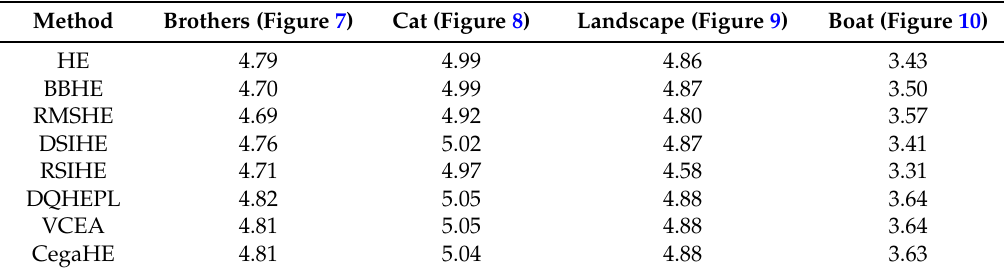
Table 2. Discrete entropy values of compared